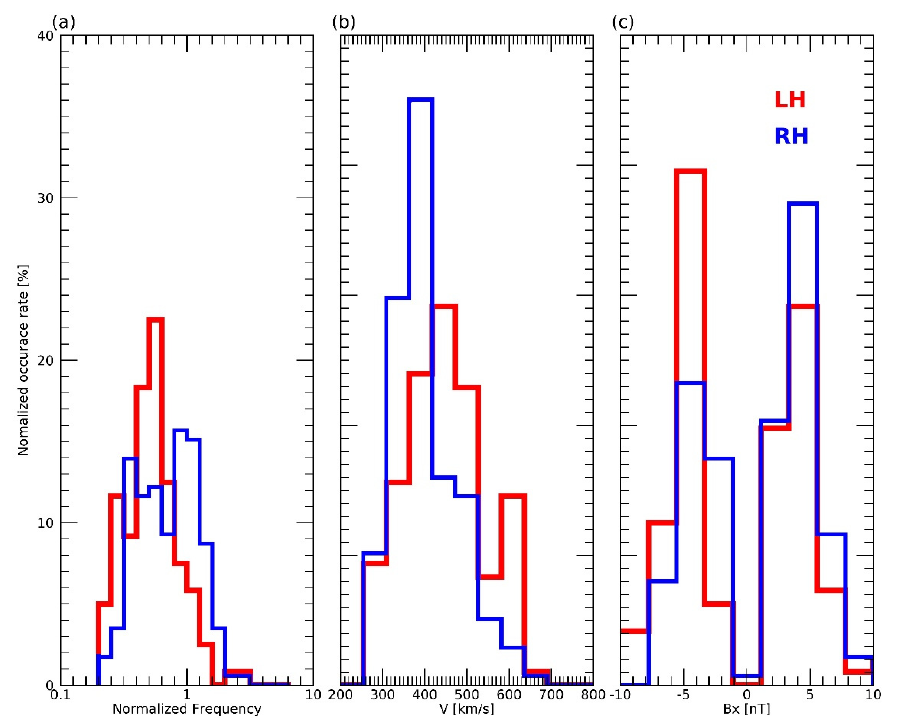
Figure 11. Histograms of the corresponding conditions of the wavy intervals: ( a ) the frequency normalized by the corresponding ion cyclotron frequency, ( b ) solar wind speed, and ( c ) B X component. The blue lines represent the results from the right-hand polarized intervals, and red lines represent the results from the left-hand polarized intervals.